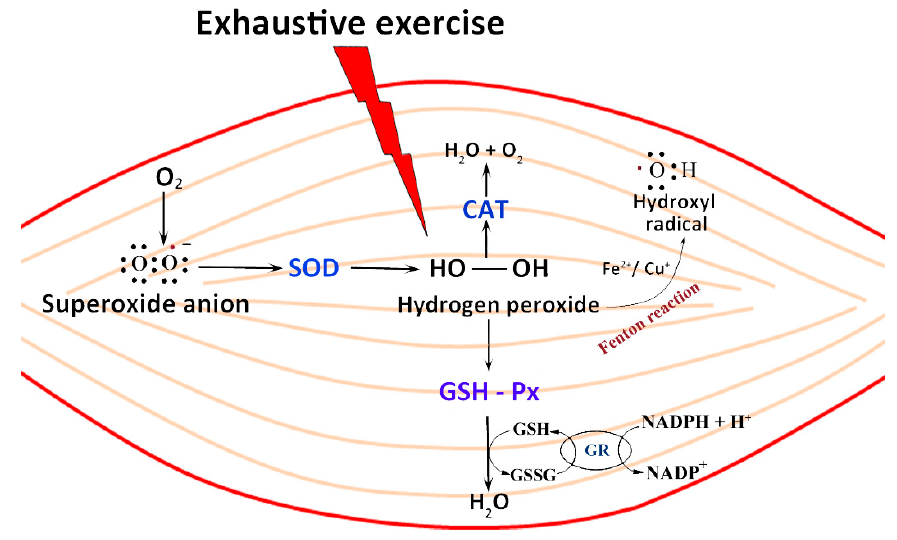
Figure 3. Antioxidant enzyme activity to counteract reactive oxygen species (ROS) production and accumulation in skeletal muscle cells after exercise. Exhaustive exercise induces an increased production of reactive oxygen species: superoxide anion (O 2- ), hydrogen peroxide (H 2 O 2 ) and hydroxyl radical (OH.) according to the Fenton reaction. Catalase (CAT), glutathione transferase (GSH), glutathione peroxidase (Px), and superoxide dismutase (SOD), work to maintain a state of oxidative balance, producing water and oxygen. Glutathione disulfide (GSSG), Glutathione reductase (GR), nicotinamide adenine dinucleotide phosphate hydrogen (NADPH) and nicotinamide adenine dinucleotide phosphate (NADP).